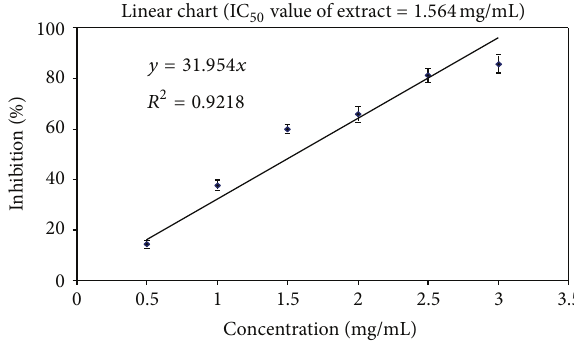
Figure 1: Inhibition effect of CCT fruits extract on the DPPH free radical at